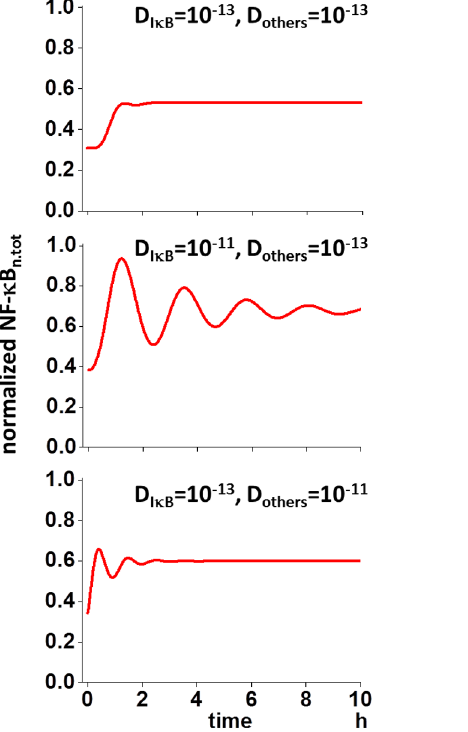
Figure 5. Rescue simulation for the oscillation of nuclear NF- k B. Oscillation was rescued by increasing D for I k B (10 2 11 m 2 /s) keeping D for other proteins small (10 2 13 m 2 /s, middle) from the non-oscillating condition where D for I k B and other proteins were 10 2 13 m 2 /s (top). In contrast, oscillation was not rescued when D for other proteins were increased while D for I k B was kept small (bottom) confirming the hypothesis shown in Figure.4A.